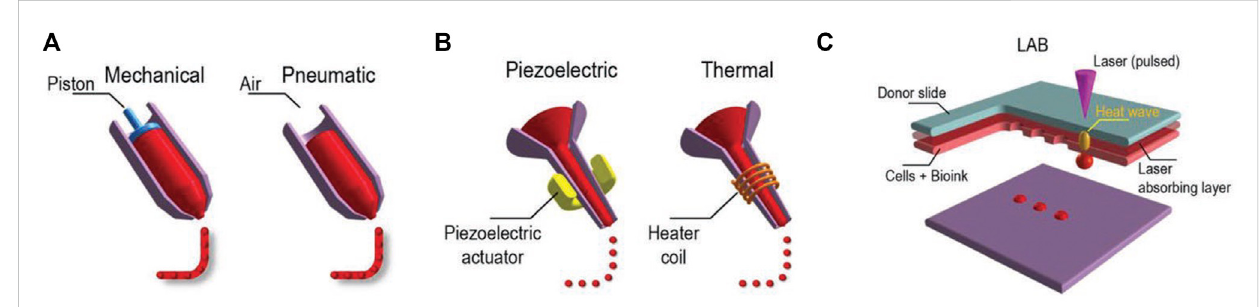
FIGURE 2 Threemajorbioprintingtechniques (A) extrusion-basedprintersusemechanicalorpneumaticdispensingsystemstoextrudethebioink, (B) toforce bioink droplets out of the nozzle, inkjet printers use either a pulsed heater to heat the print head producing air bubbles or a piezoelectric actuator to generate localized pressure via ultrasonic waves, and (C) laser-assisted bioprinters (LABs) use a laser beam on an absorbing substrate to generate heat waves that dispense the bioink onto a substrate. Reprinted with permission from (Ostrovidov et al., 2019) © 2019 WILEY-VCH Verlag GmbH and Co. KGaA,